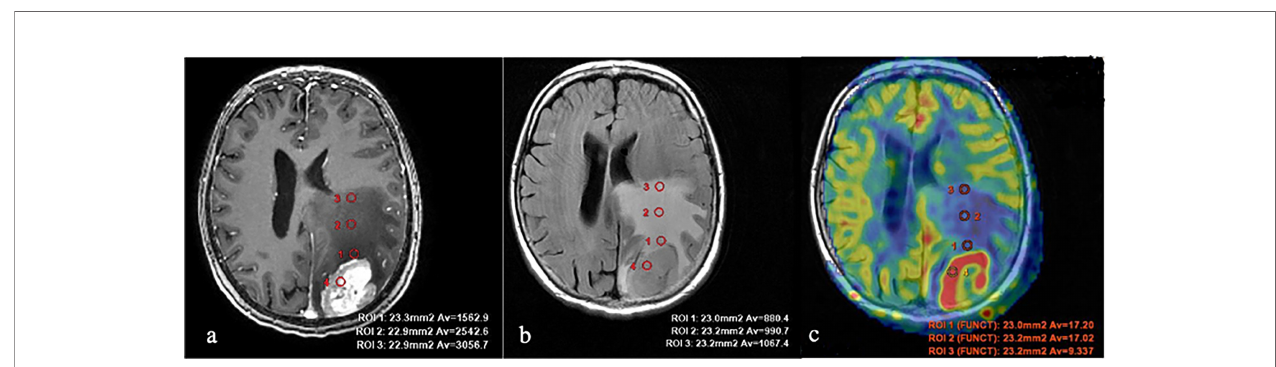
FIGURE 2 | Breast cancer metastases. (A) T1 with contrast enhancement; (B) T2-FLAIR; and (C) TBF blood fl ow maps aligned with T2-FLAIR. Measurements of hemodynamic parameters in the tumor and peritumoral zone are